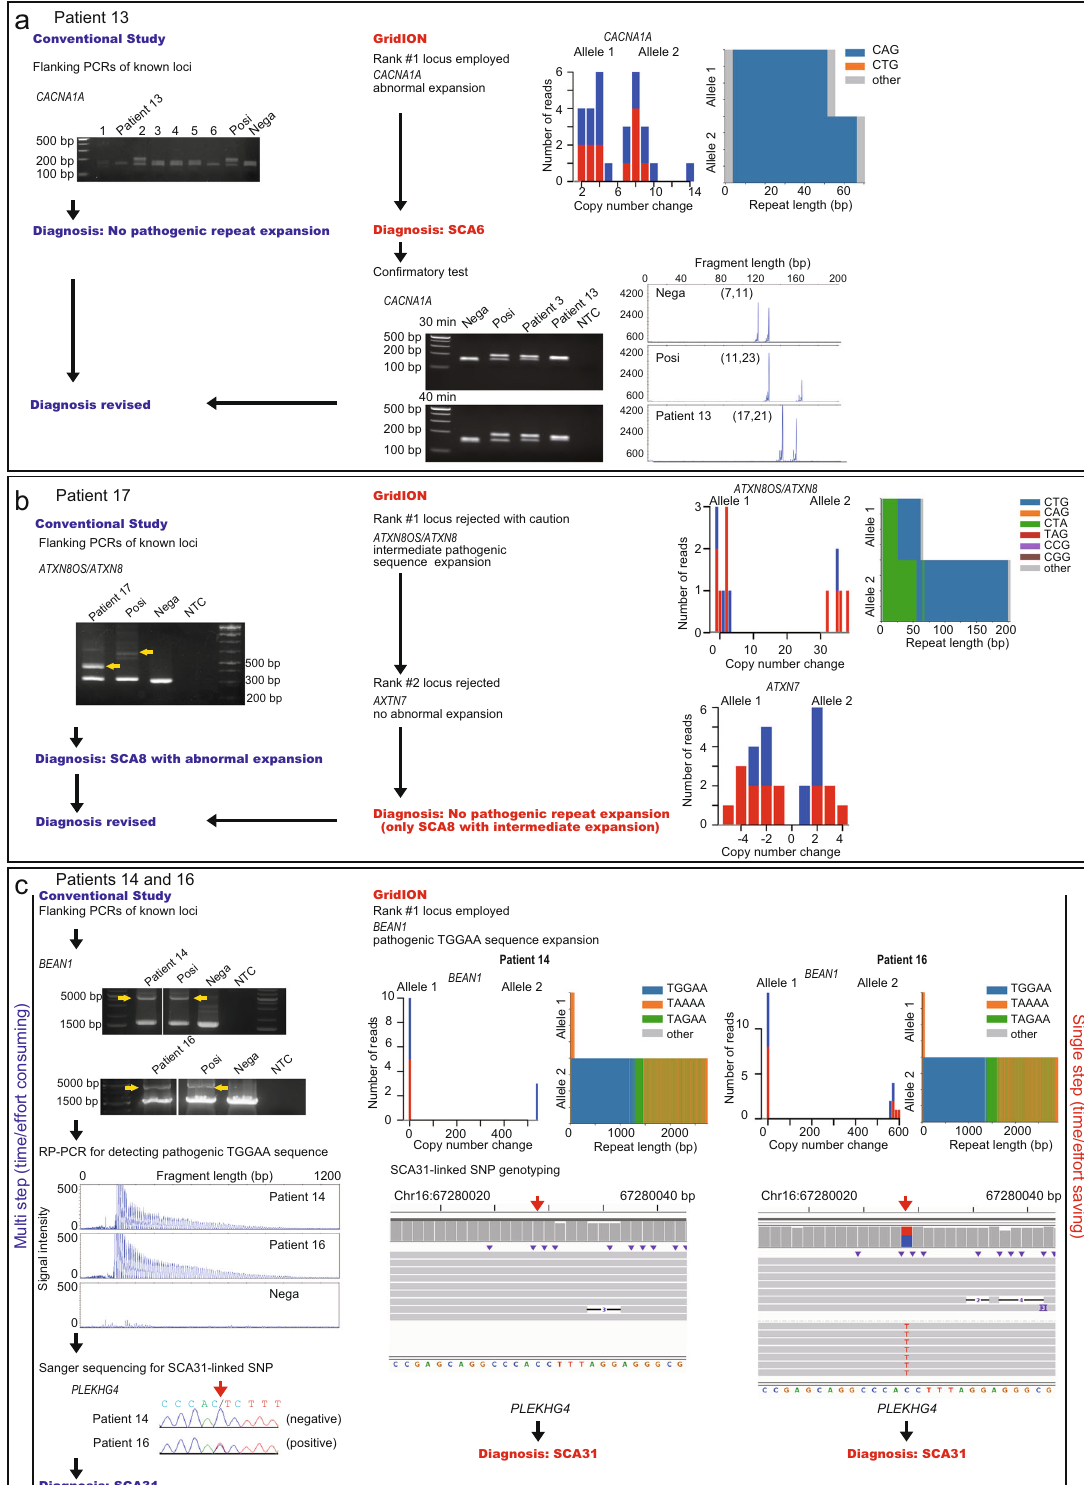
improved the sequencing accuracy and decreased “ other ” sequences (Supplementary Fig. 4a). For the AAGGG repeat expansion in RFC1 , which causes CANVAS, sequences in Patient 19 were basecalled again with sup mode. However, this resulted in even more “ other ” sequences in the consensus sequence in